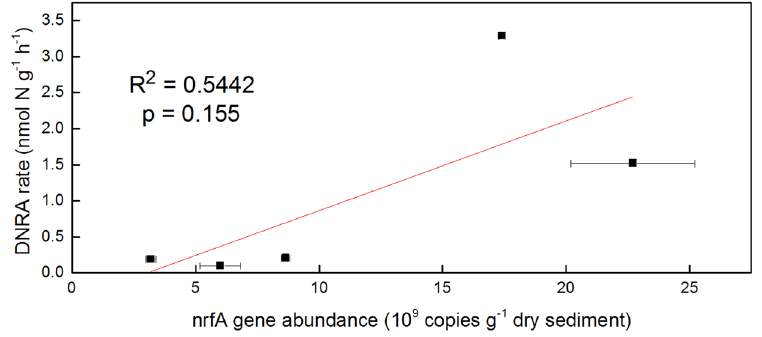
Figure 1. Correlations between DNRA rate and nrfA gene abundance. The linear regression is shown for the relation between DNRA activities and abundance. R 2 represents regression coefficient while p represents regression significance. Error bars represent standard